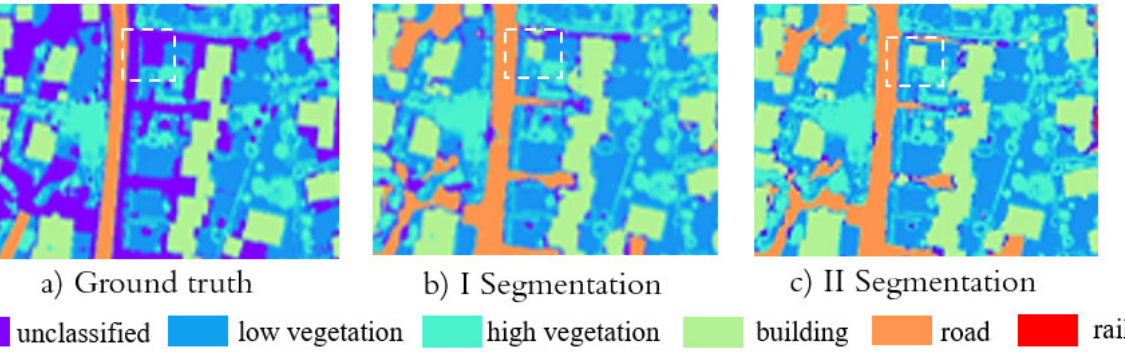
Figure 14. Improvement of the shape of an object on example building detection marked with a dashed white rectangle.